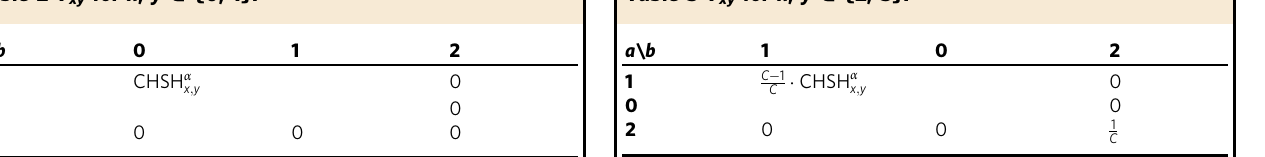
Table 2 T xy for x , y ∈ {0, 1}. Table 3 T xy for x , y ∈ {2, 3}.